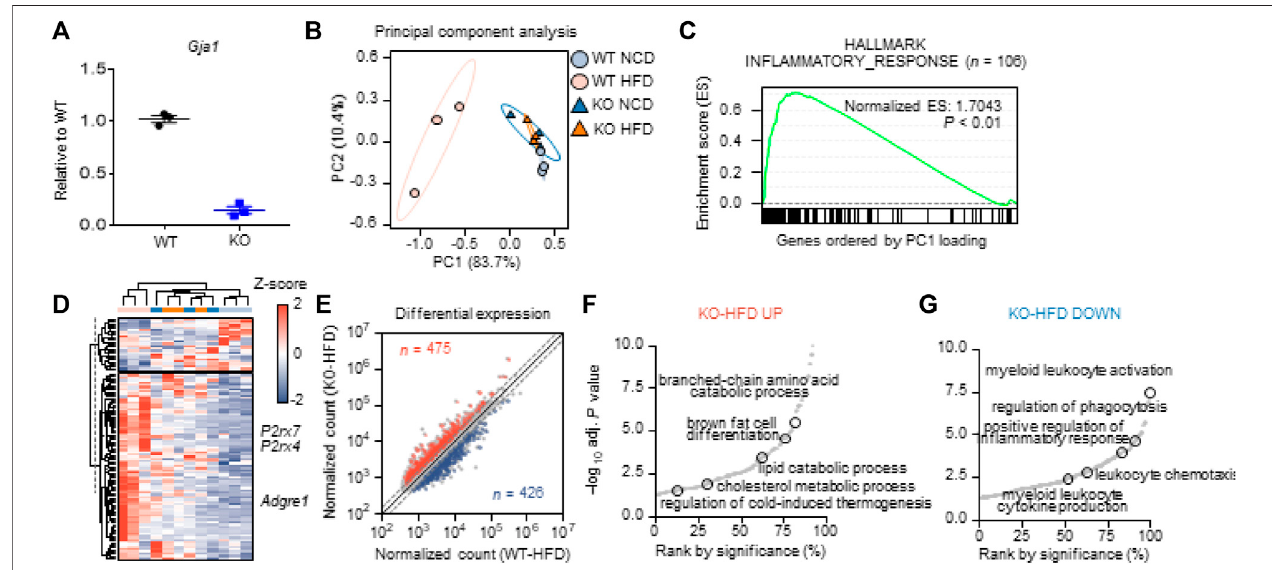
FIGURE 4 | Macrophage-speci fi c Cx43 KO reduced macrophage recruitment andpro-in fl ammatory responses in adipose tissue of mice fed HFD (A) qPCR analysisof Gja1 in MACS-isolated F4/80+ macrophages from gonadalwhiteadipose tissue (gWAT) ofWT and Cx43 MKO mice( n =3) (B) Principal componentanalysis based on the expression levels of9,895 variable genes for four groups (WT-NCD, KO-NCD, WT-HFD, KO-HFD). PC1 and PC2 values were used for 2-Drepresentation (C) GSEA showing enrichment in in fl ammatory response ( n = 106) by genes largely contributed to PC1 ( p < 0.01). Among the variable genes ordered according to PC1 loading, genes associated with the in fl ammatory response were marked with a black vertical line (D) Heatmap showing expression levels of genes associated with in fl ammatory response (E) Differential expression analysis between WT-HFD and KO-HFD.The normalized counts ofeach group wereplotted, and DEGssatisfying fold change > 1.5 and p < 0.05 were presented in red and blue in case of up-regulated and down-regulated, respectively. The number of DEGs were labeled (F) Enrichment analysis using DEGs up-regulated in KO-HFD compared with WT-HFD (G) Enrichment analysis using DEGs down-regulated in KO-HFD compared with WT-HFD. Each dot represents signi fi cantly enriched gene set and selected pathways were